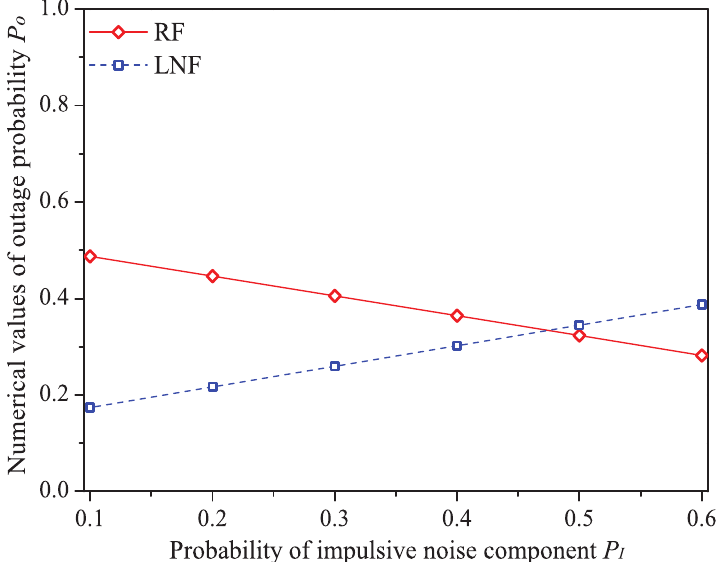
Figure 10. The numerical values of outage probability P o with different P I